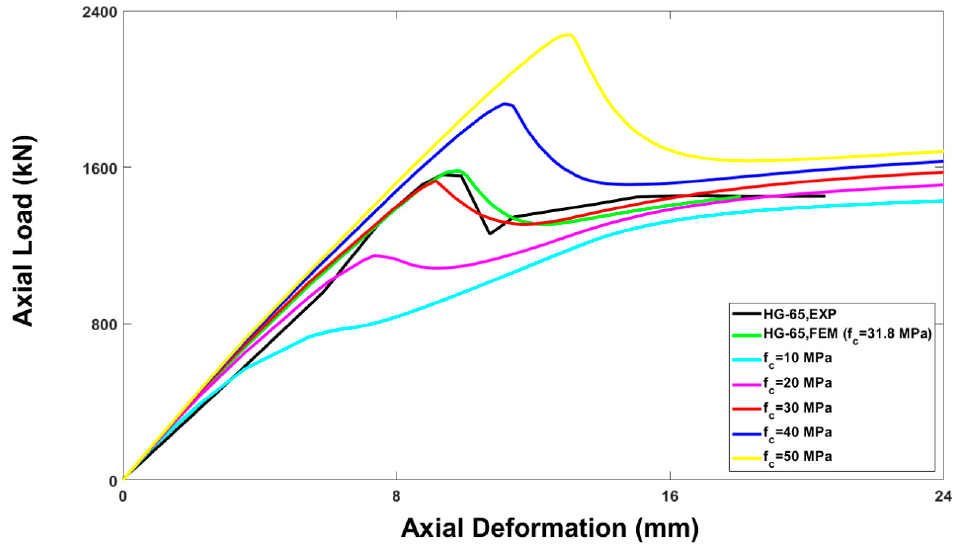
Figure 19. Effect of concrete compressive